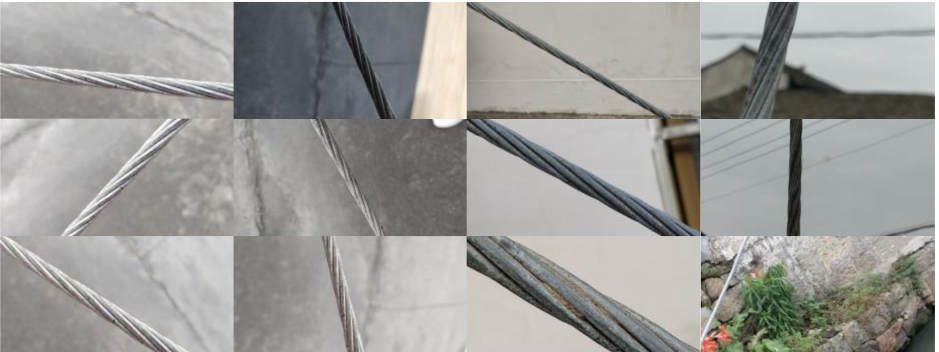
Figure 1. Discrete images for the training and validation of convolutional neural network (CNN)